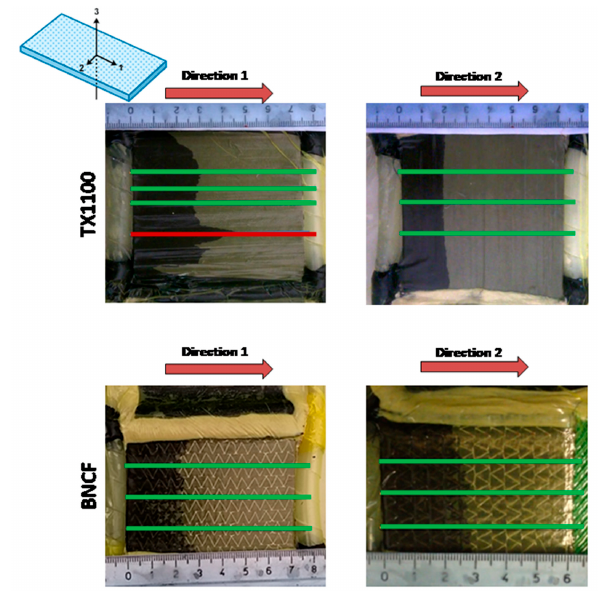
Figure 4. Flow front monitoring along the directions 1 and 2 for the two studied preforms.